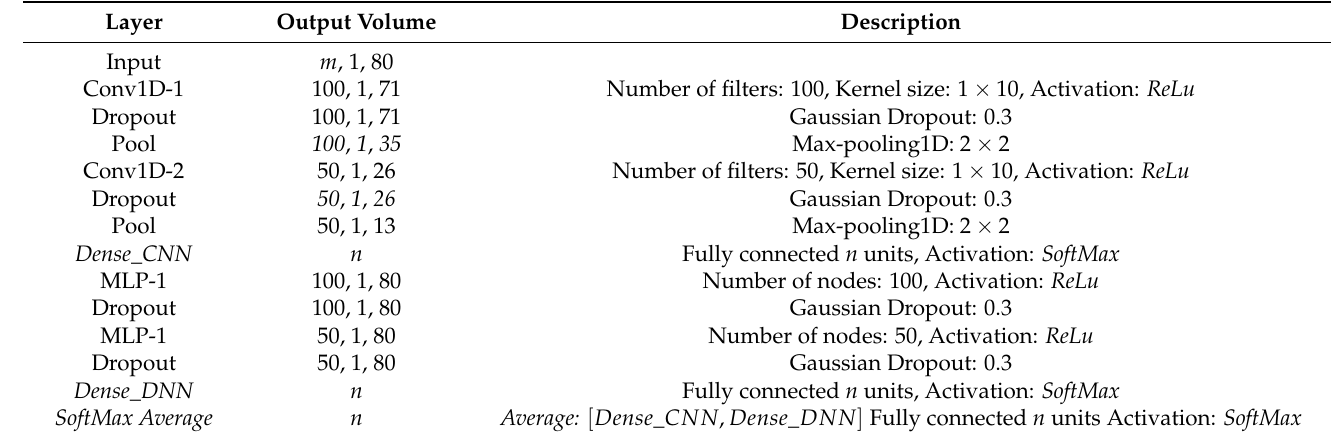
Figure 1. Proposed D-dCNN network architecture for FDI. C1, MP1, C2, and MP2 represent Convolution layer 1, Max- pooling layer 1, Convolution layer 2, and Max-pooling layer 2, respectively. Table 1. Architecture of the proposed D-dCNN